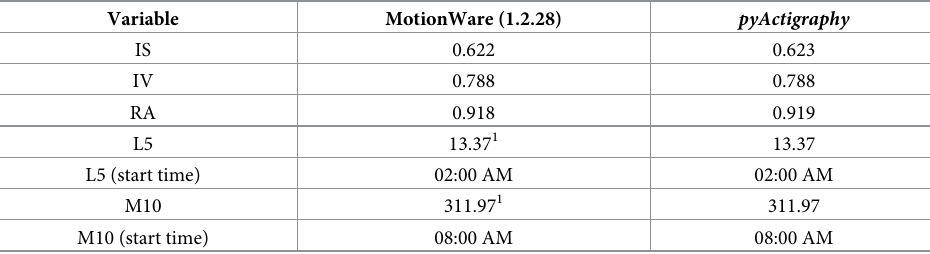
Table 1. Values of the rest-activity rhythm variables obtained with Motionware (1.2.28) and pyActigraphy